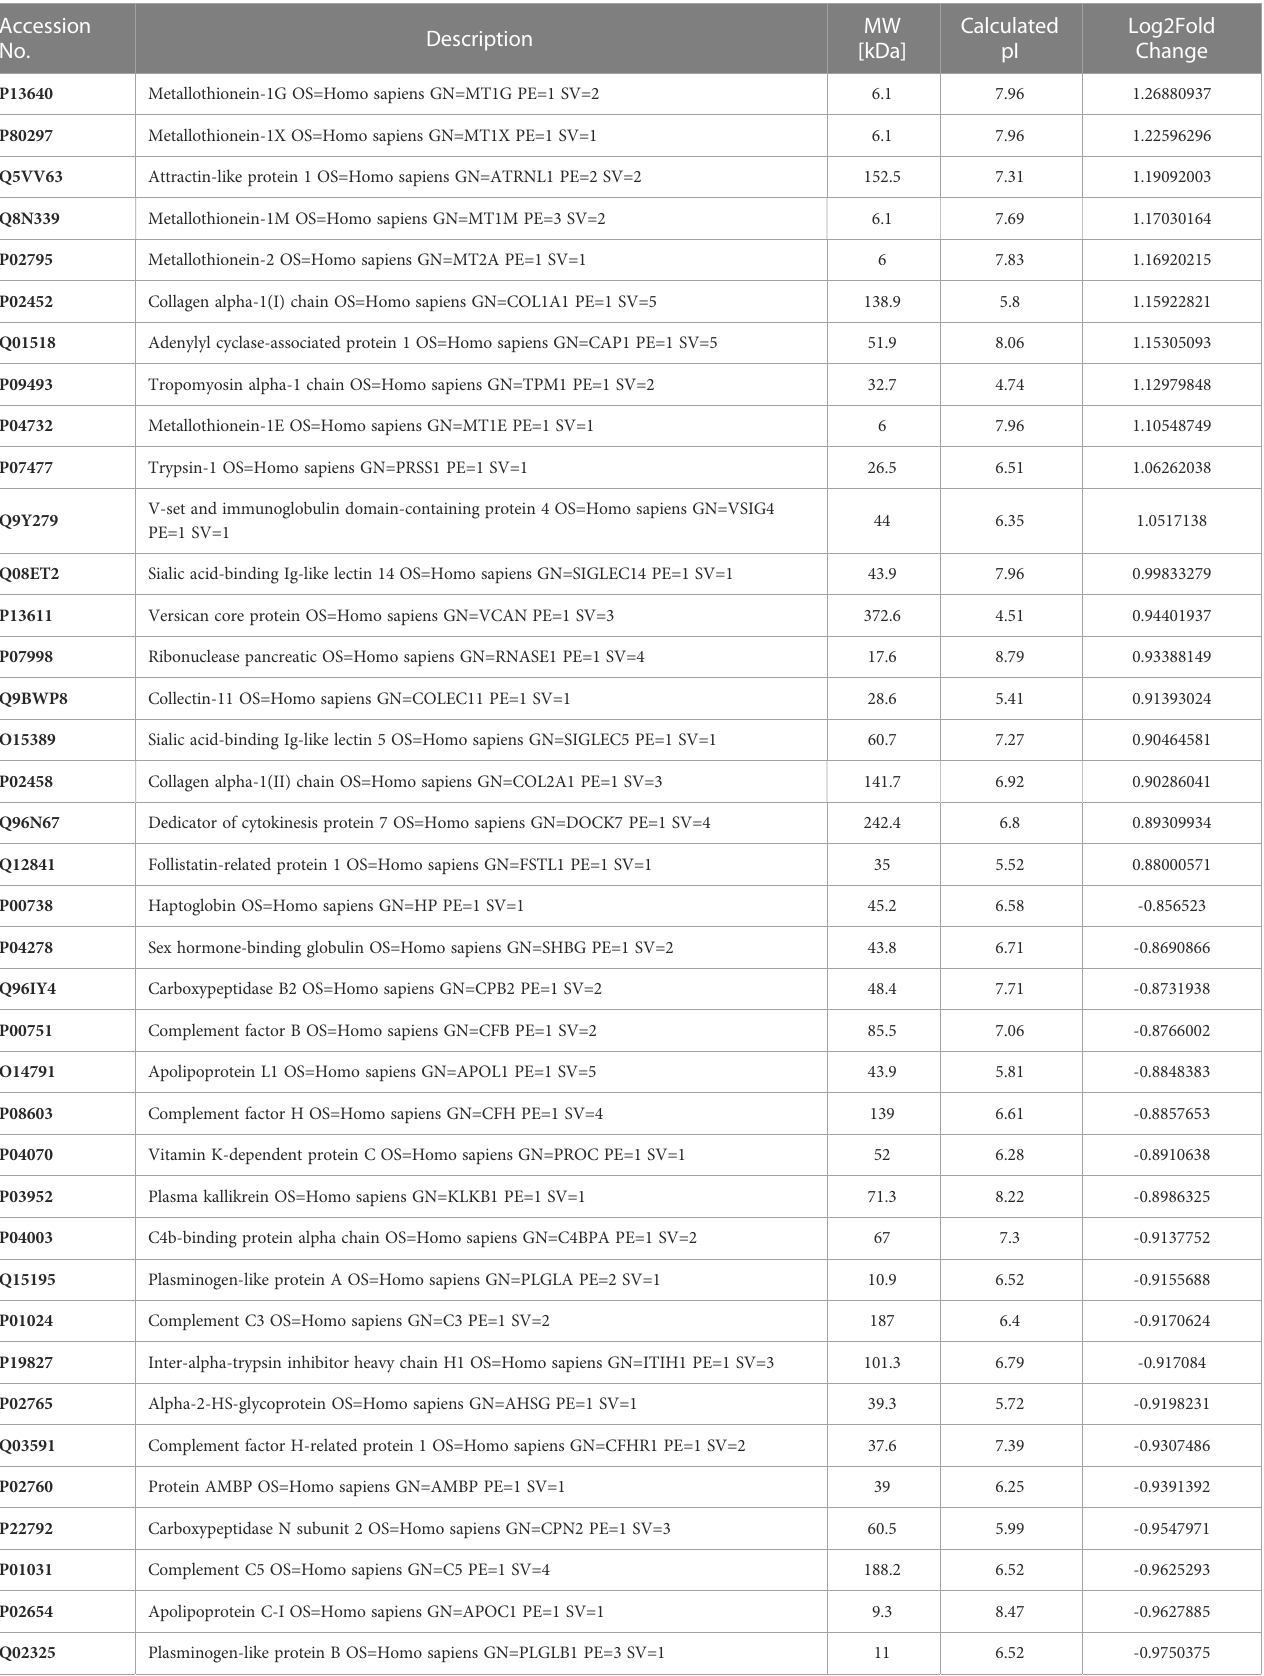
TABLE 5 Differentially expressed proteins in Group 2 (ACLFprogression to AKI; n=10) vs Group 1 (ACLF no-progression to AKI; n=9). Accession